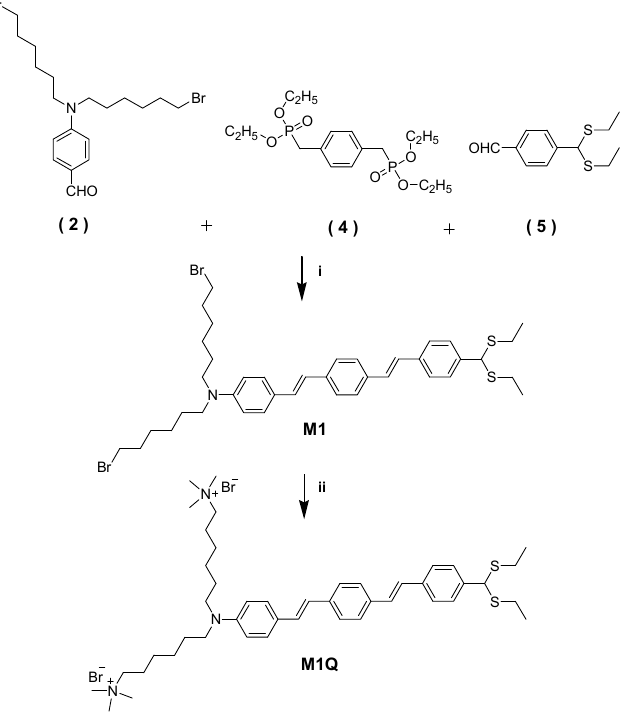
Scheme 1. Synthetic scheme: ( i ) Potassium t -butoxide, THF, 0 ◦ C, 1 h; ( ii ) 30% aq trimethylamine, THF/MeOH, room temperature, 48 Table 1. Optical properties of M1, M1-CHO, M1Q, and M1Q-CHO.